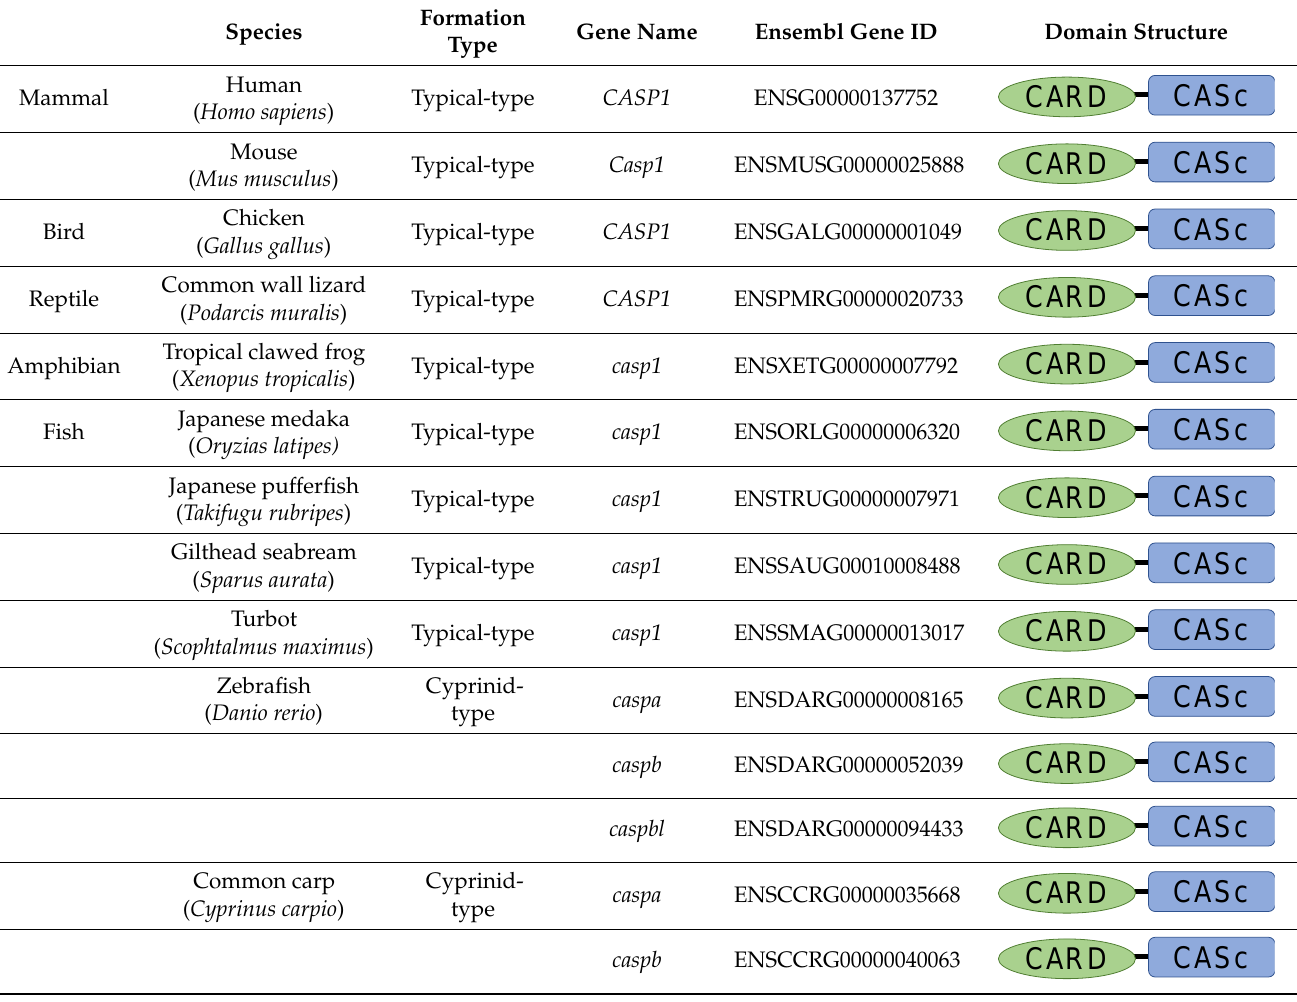
Table 1. Structures of typical and cyprinid-types pro-Caspase 1 in vertebrates.